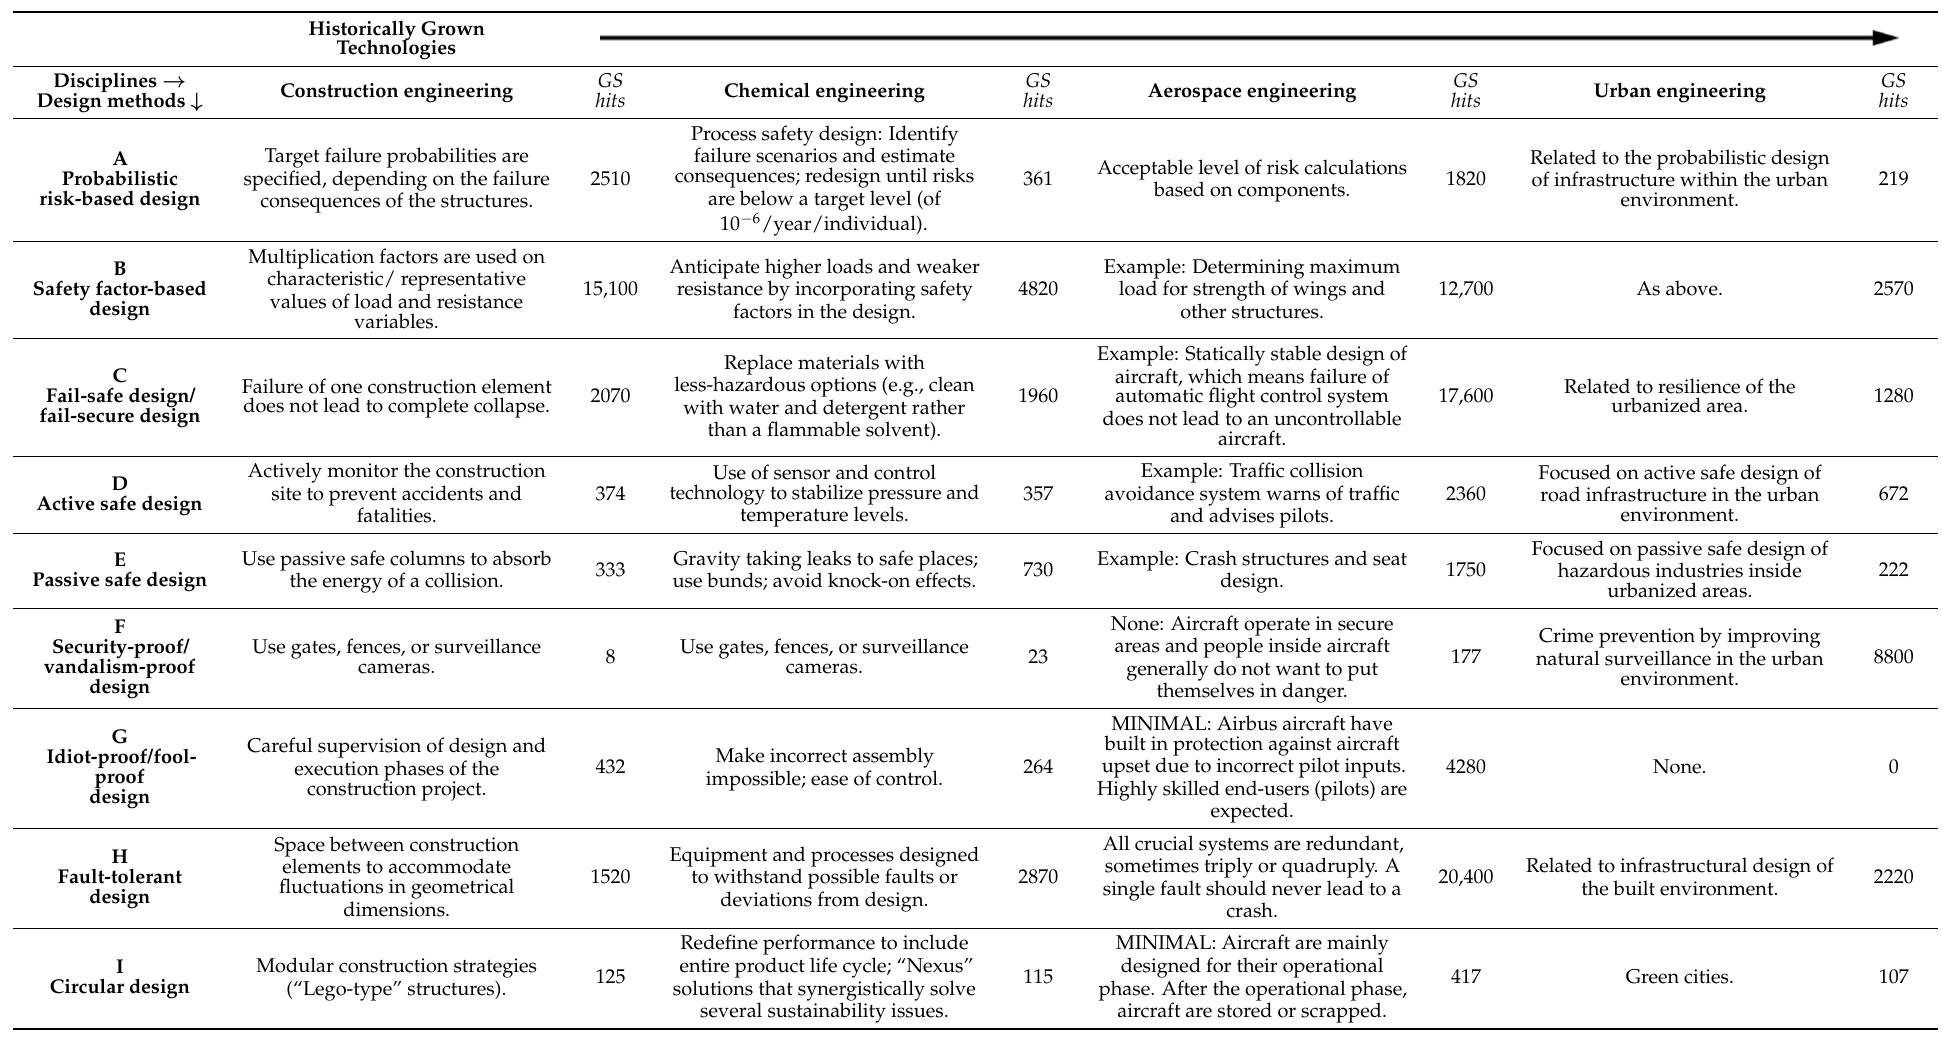
Table 2. Manifestations of risk management strategies in different disciplines.